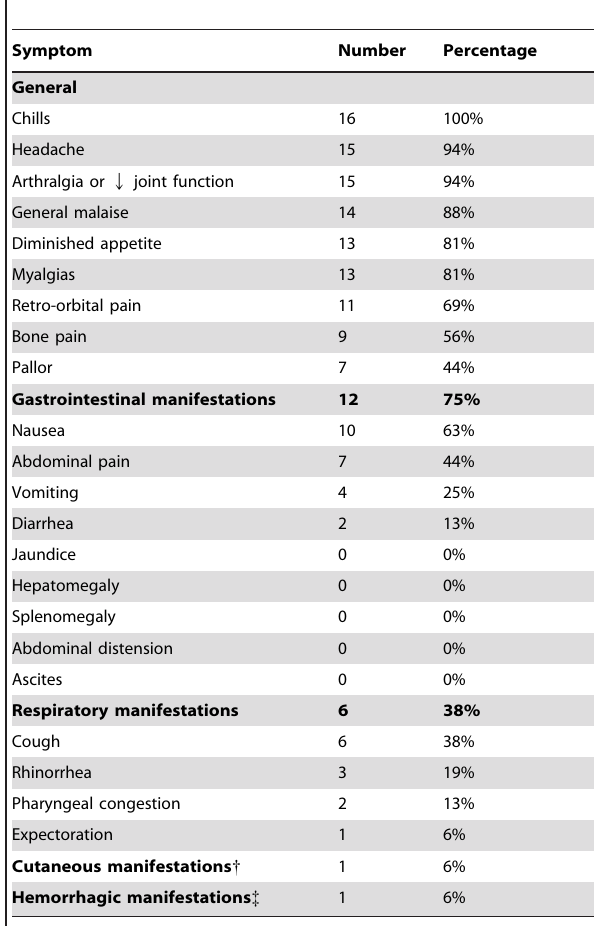
Table 2. Clinical signs and symptoms among patients (n =16) infected with IQT 9924